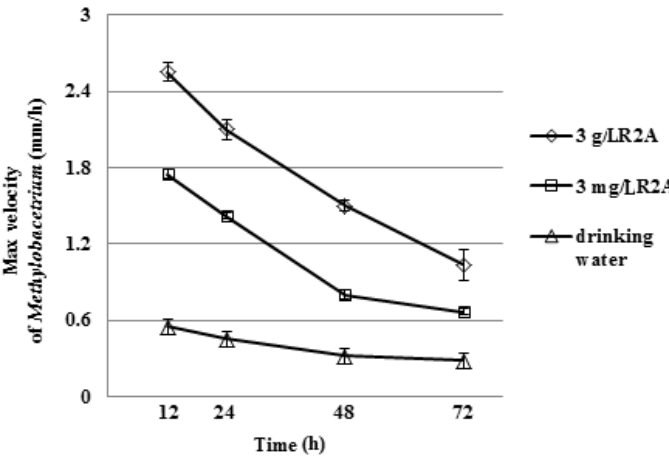
Figure 3. Motility of Methylobacterium at 0.2% agar medium after 12, 24, 48, and 72 h of incubation at 28 °C.